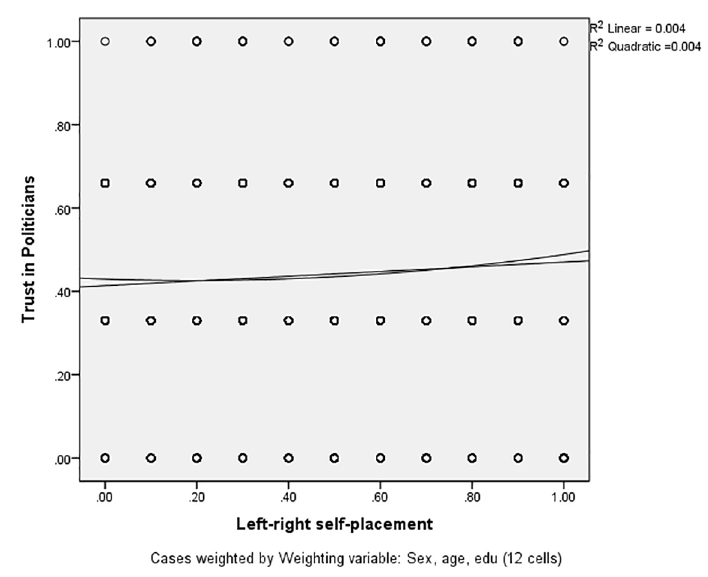
Figure 12. Linear and quadratic relationship between political ideology and political trust.